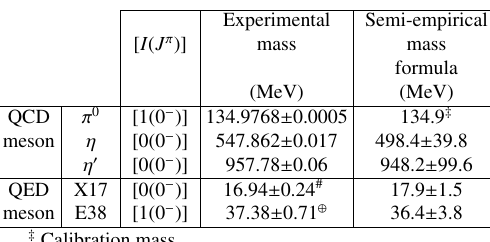
Table 1. The experimental and theoretical masses of neutral, I 3 = 0, QCD and QED mesons, obtained with the semi-empirical mass formula (9) for QCD mesons and (10) for QED